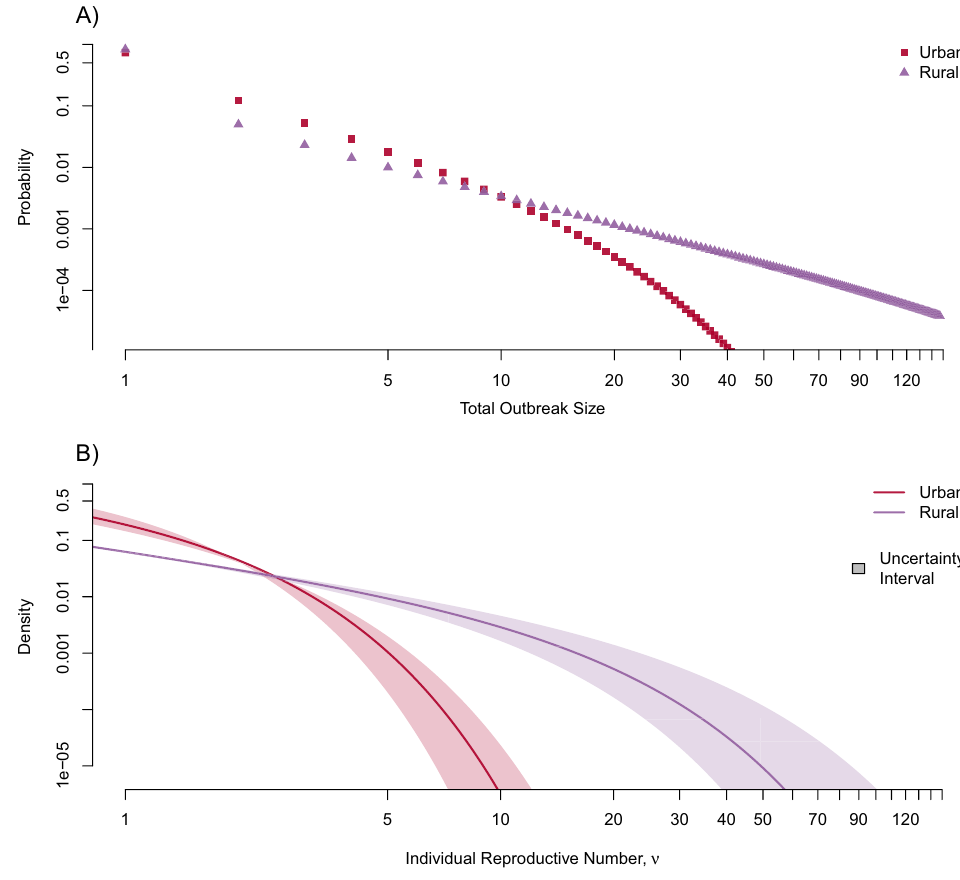
Figure 3. Underlying transmission dynamics in urban and rural models. We fit urban and rural models to the distribution of transmission cluster size data to infer the degree of individual heterogeneity in secondary cases. While all models show that TB transmission is characterized by a high degree of individual heterogeneity, the rural model suggests a substantially higher propensity for explosive outbreaks of recent transmission. ( A ) Probability of observing large outbreaks originating from a single index case; ( B ) Probability density of expected number of secondary cases for each individual (i.e., underlying individual reproductive number, ν ). The uncertainty interval integrates across the entire range of 95% confidence intervals for both